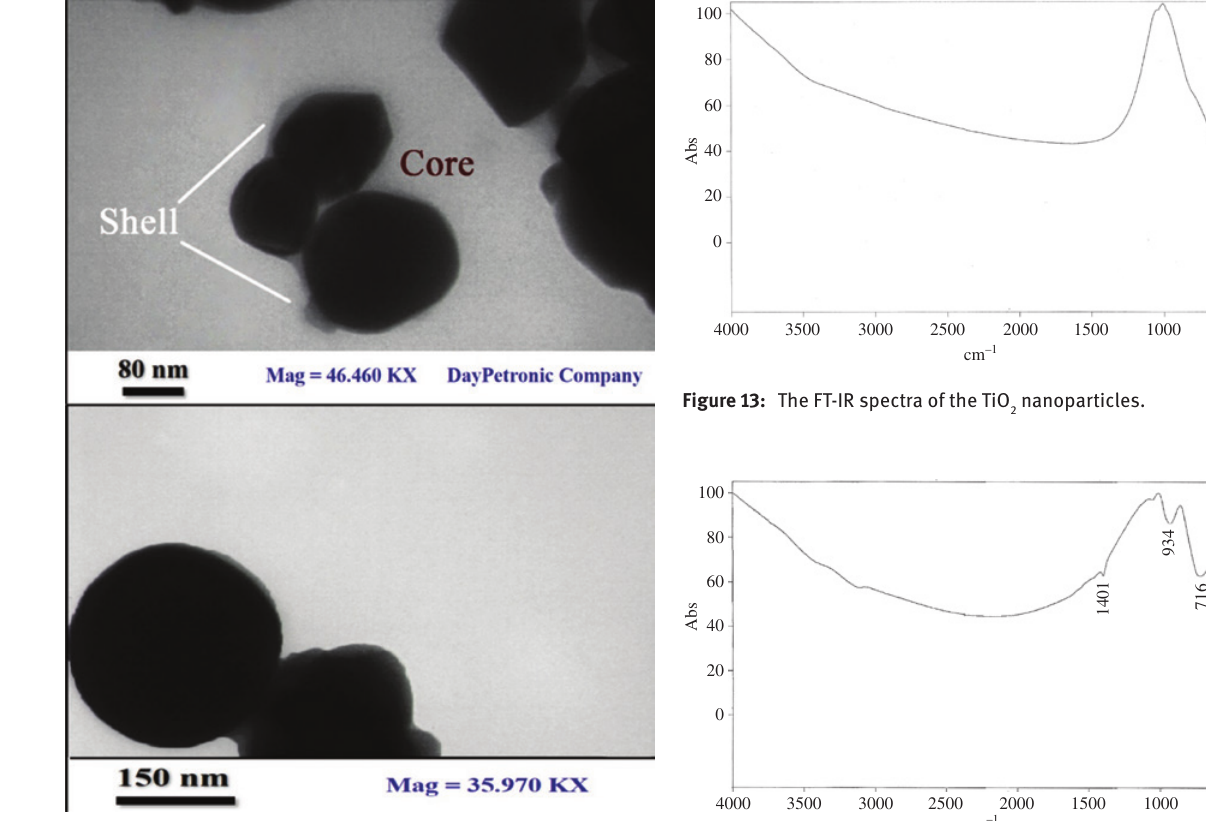
O -TiO nanocomposites. 12 19 2